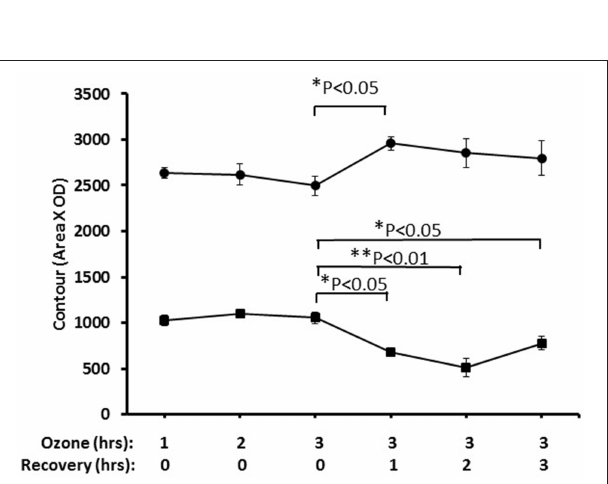
FIGURE 8 | Nuclear and cytoplasmic levels of NRF2 in lung tissue after ozone exposure. Mice were exposed to 2 PPM ozone for 1, 2, or 3h and then allowed to recover for either 0, 1, 2, or 3h after exposure. Lungs were then removed, and nuclear and cytoplasmic extracts prepared and run on SDS-PAGE gels. NRF2 levels were quantitated by Western blot ECL and densitometry (• nuclear, (cid:4) cytoplasmic). The results indicated the time-dependent translocation of Nrf2 from cytoplasm to nucleus after ozone exposure (* P < 0.05; ** P <